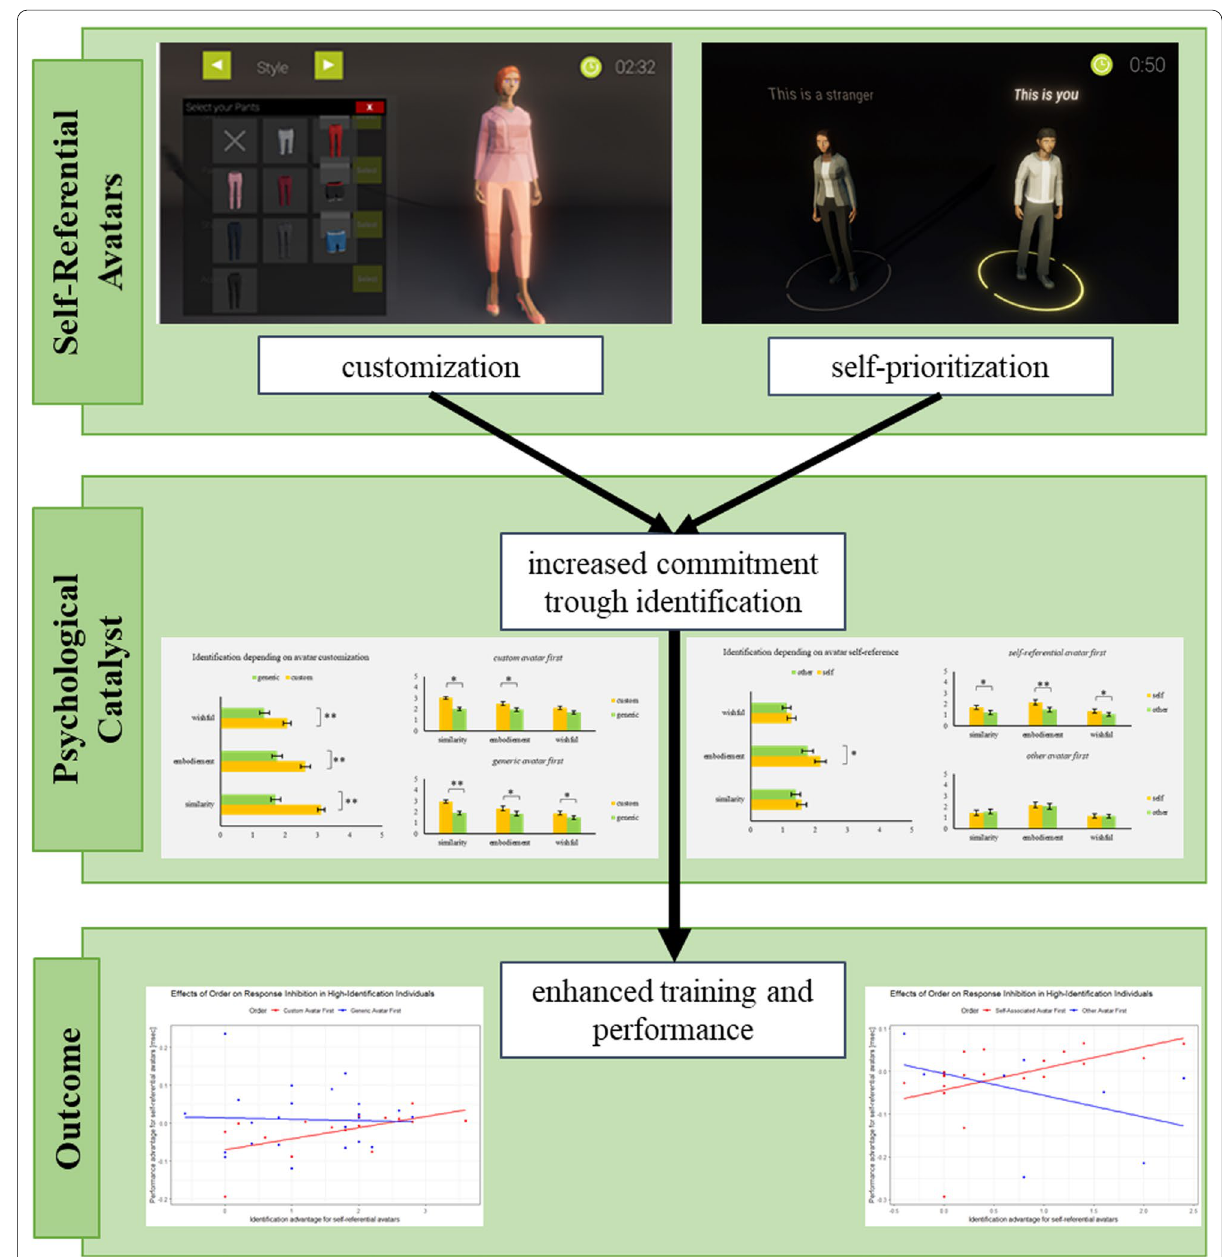
Fig. 9 Summary of the results and the proposed underlying explanation for them. In short, self-referential avatars are hypothesized to